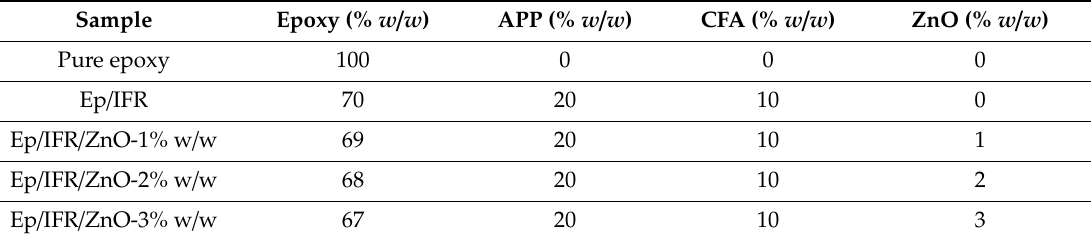
Table 1. Composition of the